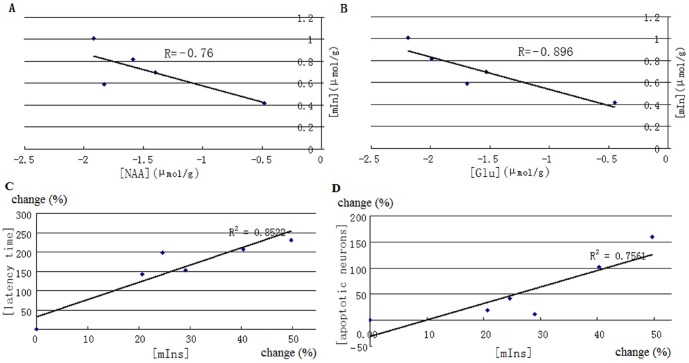
Correlation between the changes in mIns and NAA (A), mIns and Glu (B), mIns and latency time (C), mIns and apoptotic neurons (D) in senescent mice at different time point.